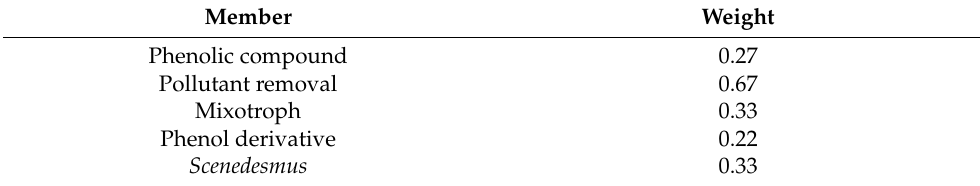
Figure 12. Thematic network for the second period (2006–2010). Table 6. The weight of lines connected to the main theme